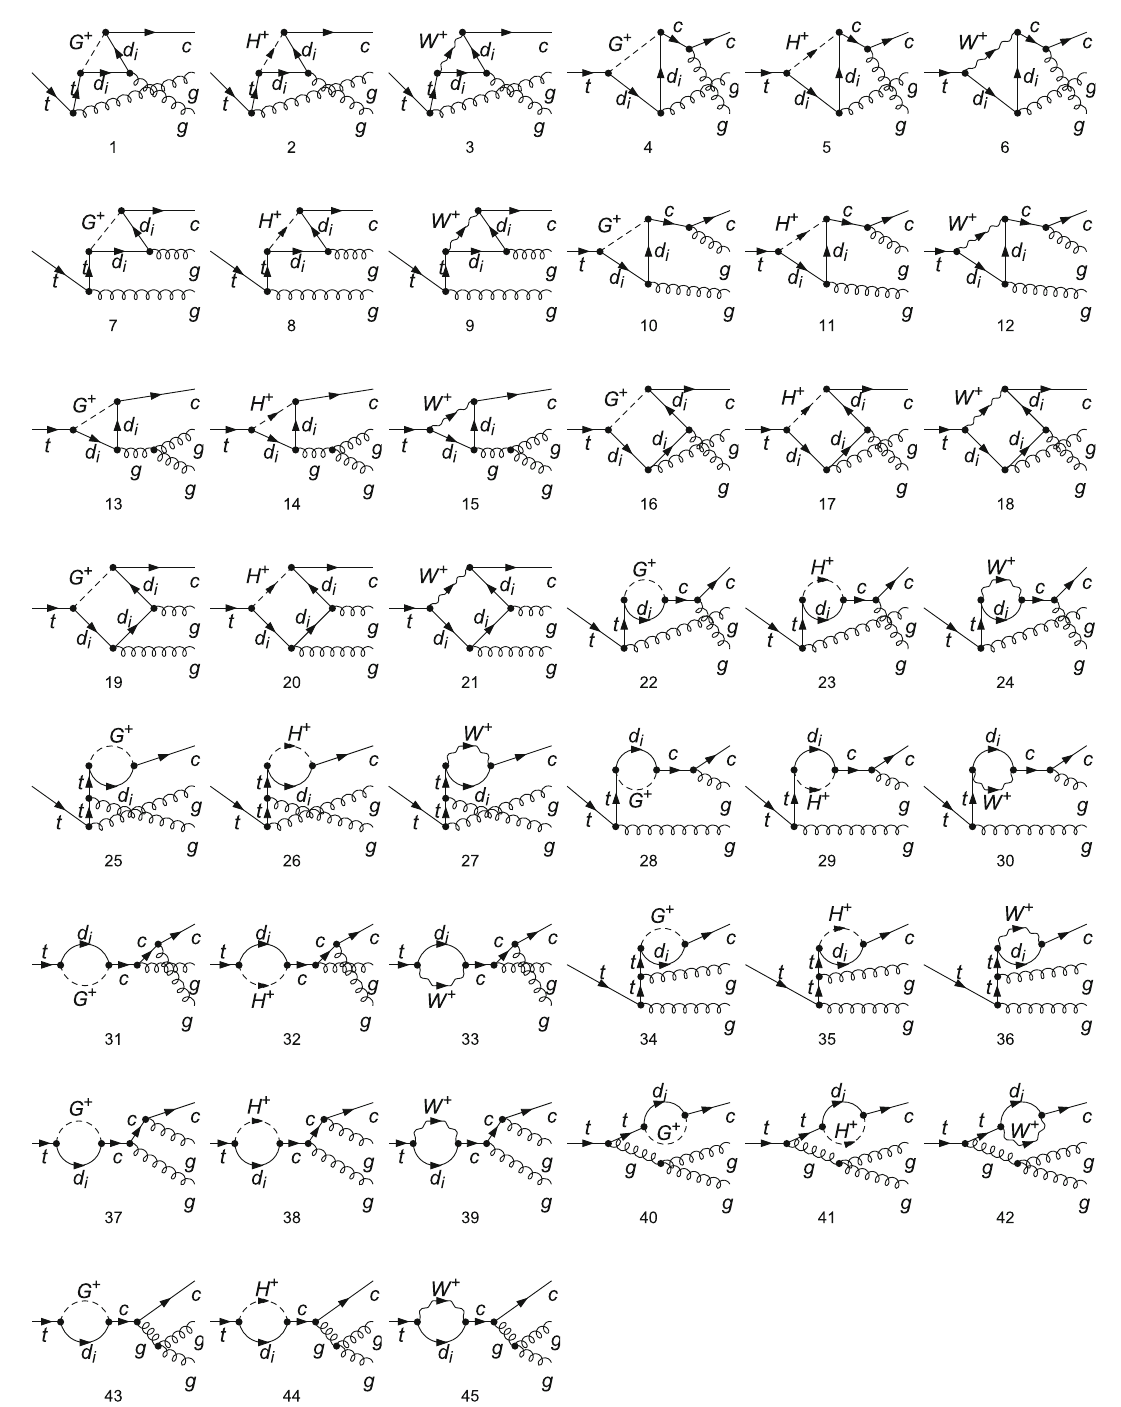
Fig. 2 One-loop Feynman diagrams contributing to the t → cgg decay in the ’t Hooft–Feynman gauge, with d i = { d , s , b } , in the A2HDM. The first 1–15 diagrams are the vertex diagrams, the diagrams 16–21 are the box diagrams, and the rest 22–45 are the t − c fermion self-energy